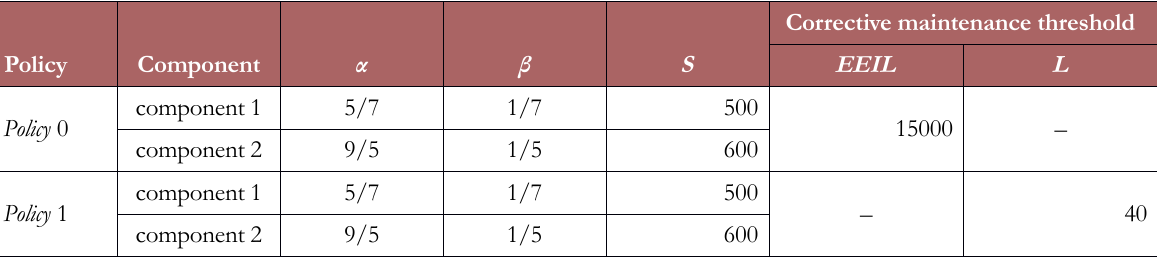
Table 1. Parameters for two policies